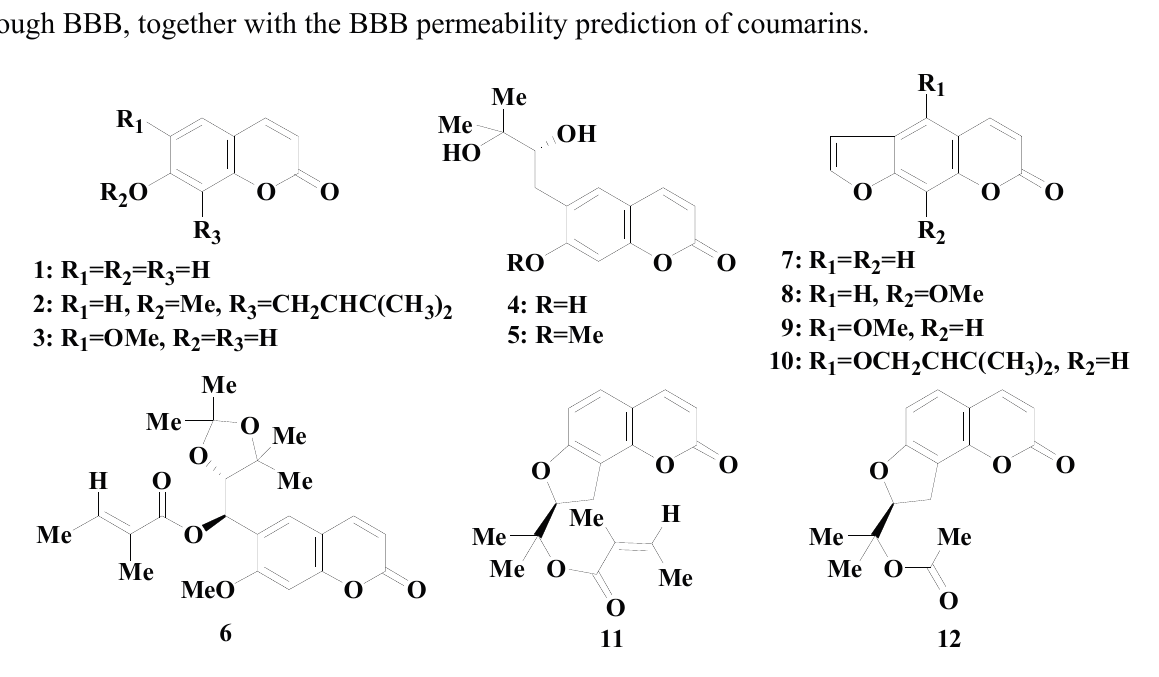
Figure 1. Chemical structures of coumarins from Angelicae Pubescentis Radix: umbelliferone ( 1 ), osthol ( 2 ), scopoletin ( 3 ), peucedanol ( 4 ), ulopterol ( 5 ), angepubebisin ( 6 ), psoralen ( 7 ), xanthotoxin ( 8 ), bergapten ( 9 ), isoimperatorin ( 10 ), columbianadin ( 11 ) and columbianetin acetate ( 12